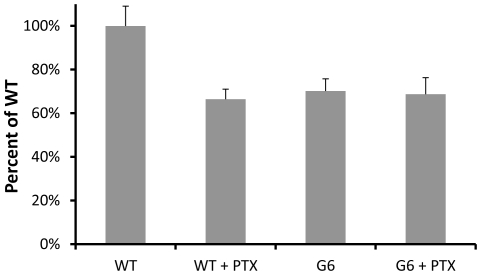
Activated pertussis toxin treatment on the G-protein activity of microsomes.As an alternative to treating whole cells with PTX, Tetrahymena microsomes were treated with activated toxin. As before, G6 microsomes showed decreased binding but there was no decrease when treated with activated PTX. This suggests that the Gpcr6p pathway is working exclusively through a PTX sensitive G-protein. (n = 3 determinations for 3 membrane preparations). Significance determined by ANOVA, Tukey multiple pair wise analysis (95% and 99% C.I.'s).